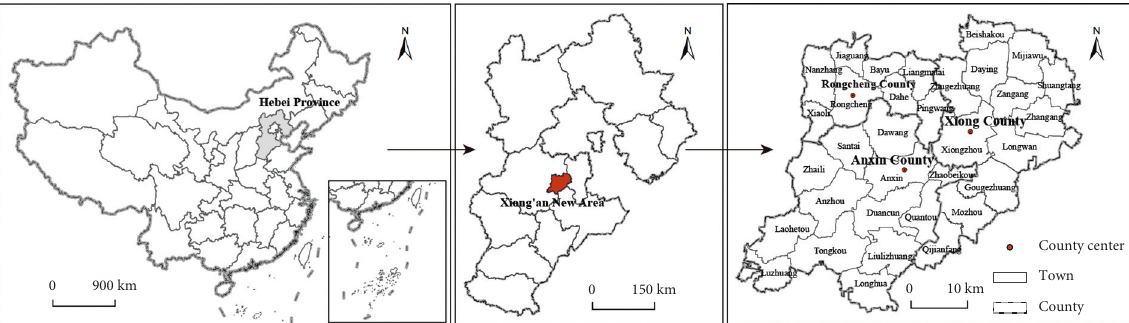
Figure 2: Profile of Xiong’an New